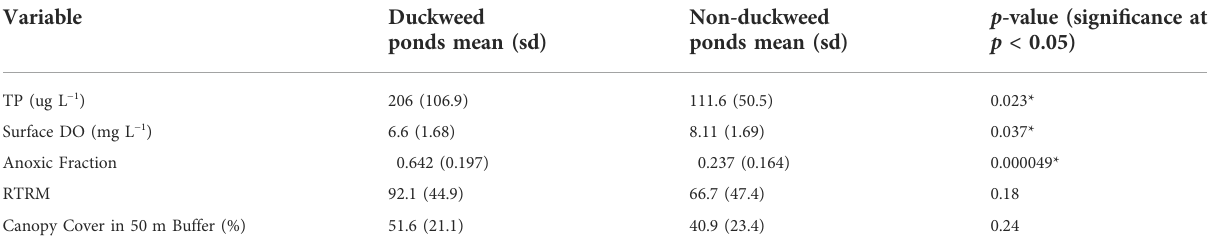
TABLE 3 Mean (range) concentrations and emissions of CO 2 , CH 4 , and N 2 O for the 26 study ponds.